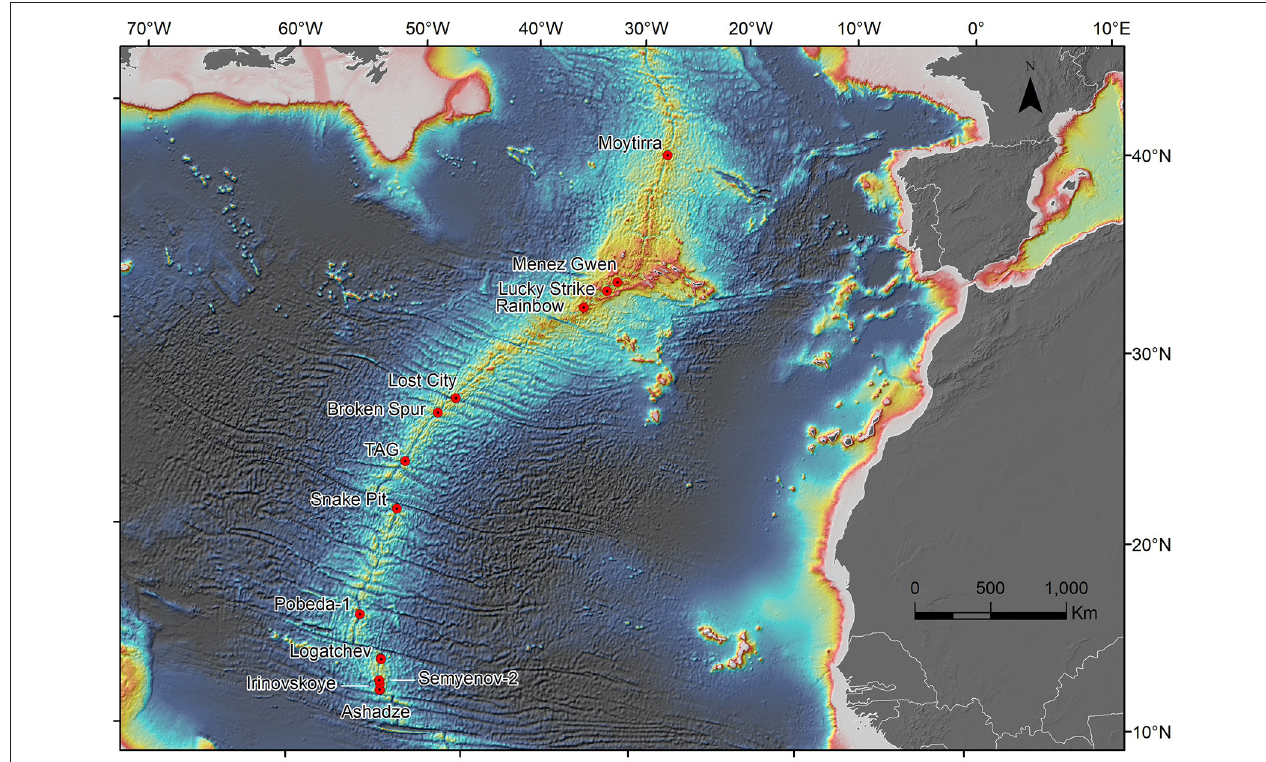
FIGURE 1 | The location of 13 hydrothermally active vent fields on the northern Mid-Atlantic Ridge. Map produced using the ETOPO1 1 Arc-Minute Global Relief Model: Procedures, Data Sources and Analysis. NGDC, NESDIS, NOAA, U.S. Dept. of Commerce, Boulder, CO. Escartin, J., M. Cannat, G. Pouliquen, A. Rabain